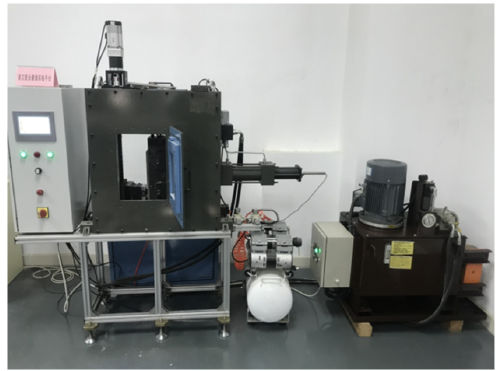
Figure 2. The combined abrasion test device for the reduced-scale SP3-I TBM cutter.